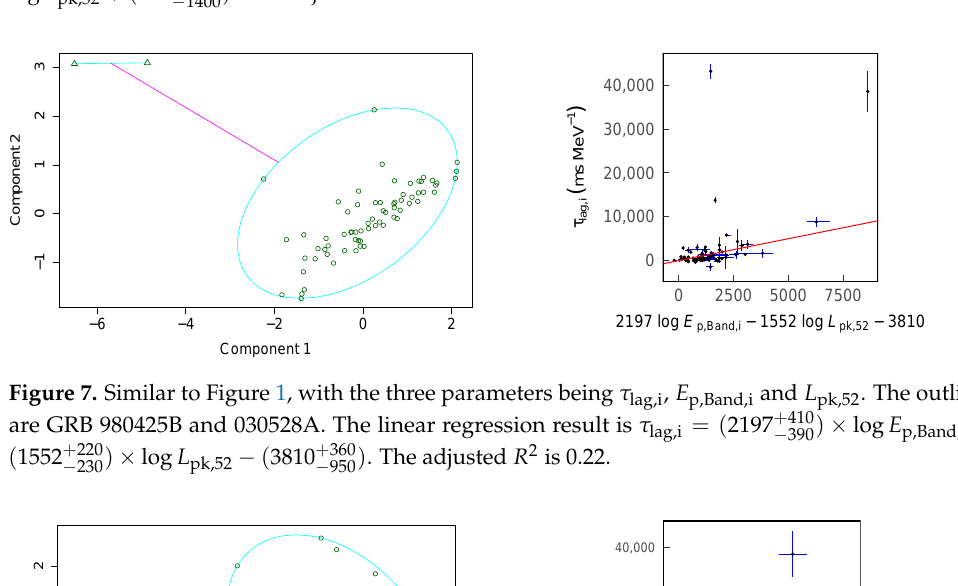
) × ( − β ) − ( 804 + 240 ) × Band − 180 370